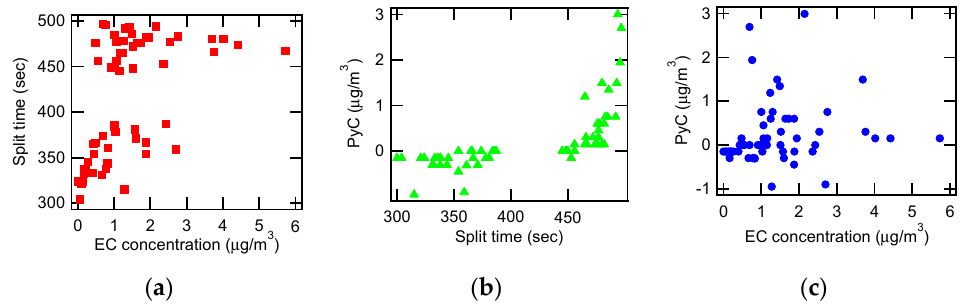
Figure 6. Relationship between split time, PyC and EC concentrations: ( a ) Split time vs. EC concentration; ( b ) PyC vs. split time; ( c ) PyC vs. EC concentration.